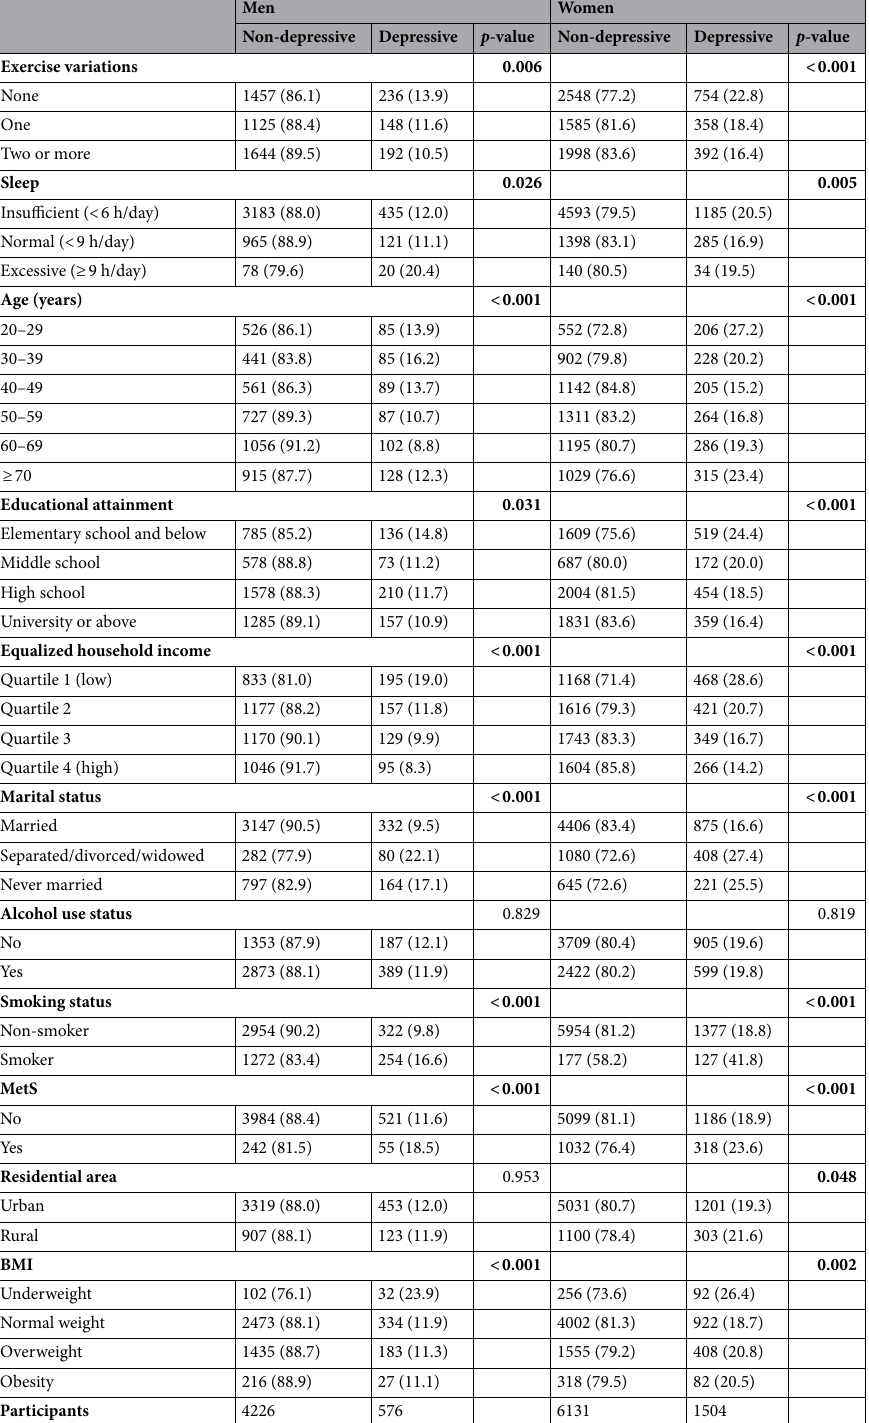
Table 1. Sociodemographic characteristics of study participants and depression (PHQ-9 ≥ 5). Categorical variables are presented as numbers and percentages. Bold values denote a p-value of <.05. PHQ-9 patient health questionnaire-9, MetS metabolic syndrome, BMI body mass